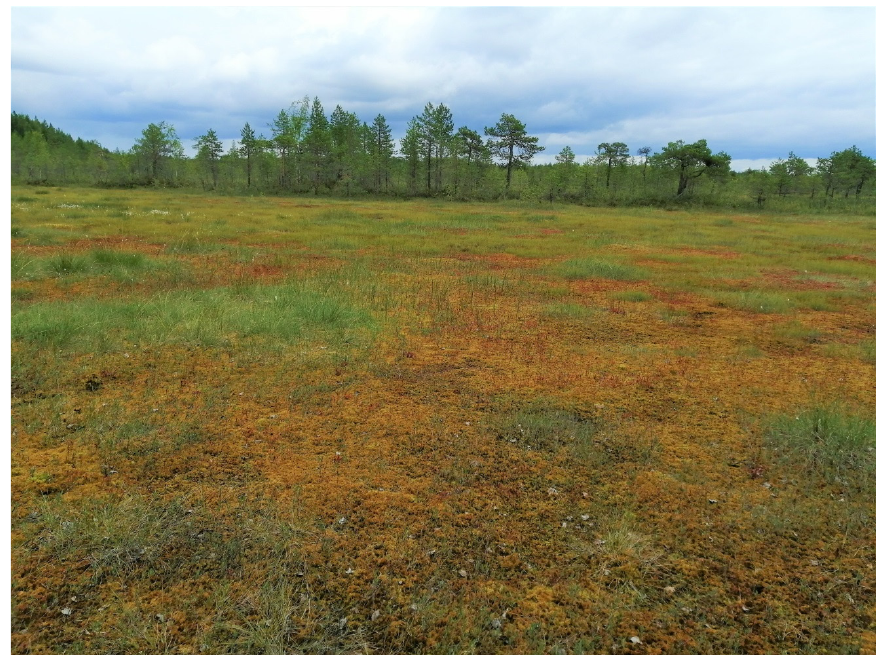
Figure A1. The Ilassky peat bog massif view in summer (Arkhangelsk Region, Russia).